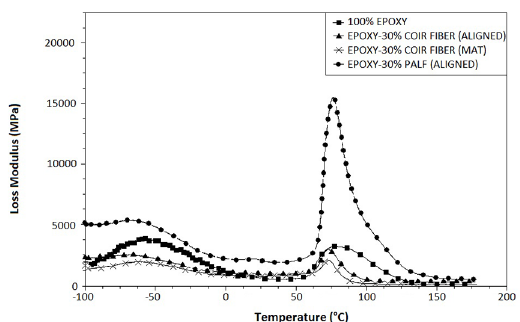
Figure 5. Effect of temperature on the loss modulus curves of the epoxy reinforced with different volume fractions of aligned coir fiber.